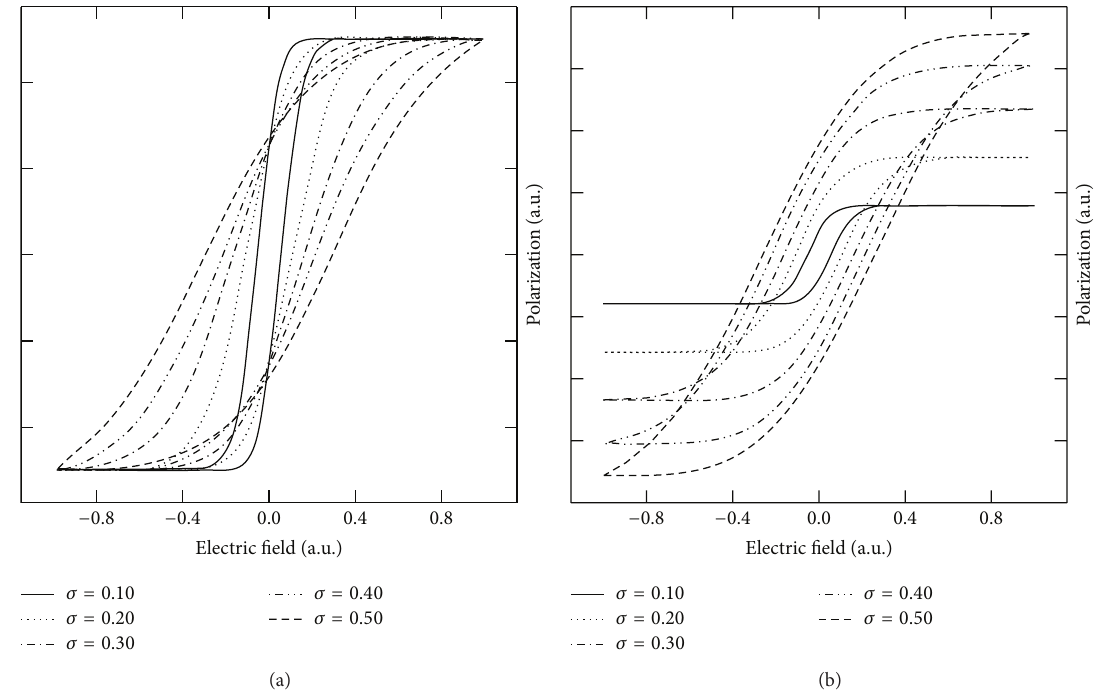
Figure 4: Hysteresis loops obtained from (a) normalized Preisach densities and (b) unnormalized Preisach densities for 𝜎 = 0.10 – 0.50